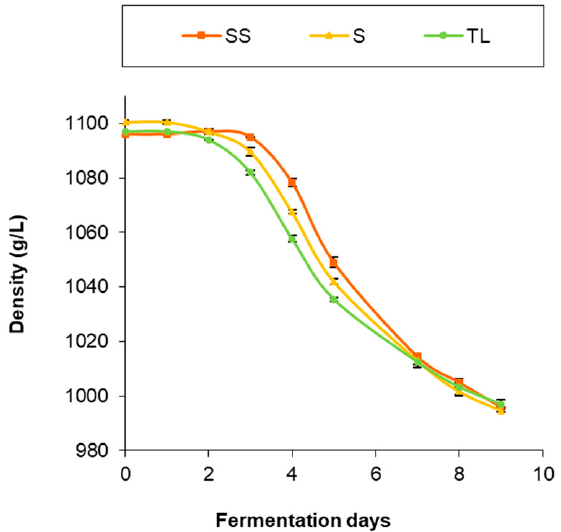
Figure 1. Evolution of density during AF in the different inoculation strategies (SS: spontaneous sulfite, S: spontaneous without SO 2 , TL: inoculation with T. delbrueckii / L. thermotolerans at vatting without SO 2 ).